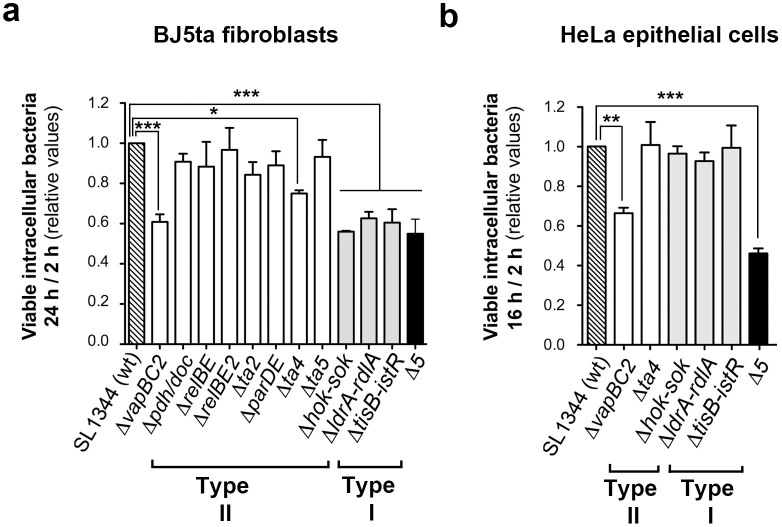
Distinct type I and type II TA modules impact fitness of intracellular S. Typhimurium in fibroblasts and epithelial cells.Shown are the survival rates of S. Typhimurium mutants lacking the indicated type I (grey bars) and type II (white bars) TA modules. (a) ratio of viable intracellular bacteria at 24 h and 2 h post-infection in human BJ5ta fibroblasts; (b) ratio of viable intracellular bacteria at 16 h and 2 h post-infection in human HeLa epithelial cells. “Δ5” refers to the Δhok-sokST ΔtisB-istRST ΔldrA-ldrAST Δta4ST ΔvapBC2ST mutant. Data are the means and standard deviations from three independent experiments. *, P = 0.01 to 0.05; **, P = 0.01 to 0.001; ***, P = < 0.001, by one-way ANOVA with Dunnett's post-test.